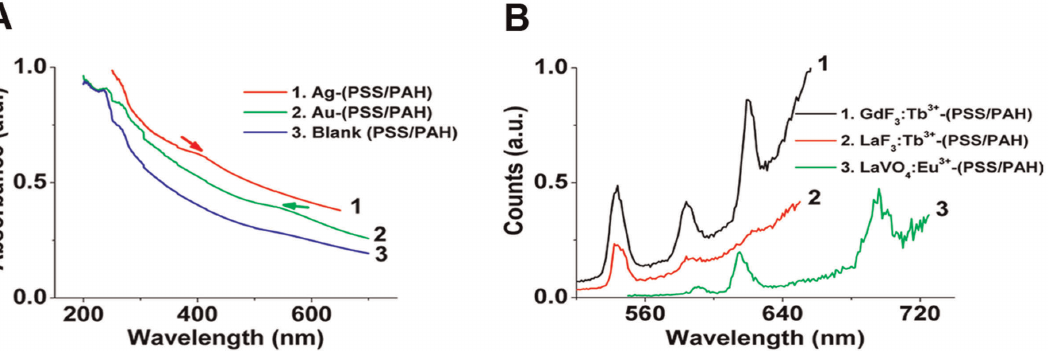
Figure 1. Optical properties of nanoparticles-loaded PSS/PAH capsules. (a) UV-Vis absorbance spectra of (1) Ag and (2) Au nanoparticles- loaded PSS/PAH capsules and (3) blank PSS/PAH capsules; (b) photoluminescence emission spectra of (1) GdF 3 :Tb 3 + (5%), (2) LaF 3 :Tb 3 + (5%) and (3) LaVO 4 :Eu 3 + (5%) nanoparticles-loaded PSS/PAH capsules [Excitation wavelength used was 488 nm for GdF 3 :Tb 3 + (5%) and LaF 3 :Tb 3 + (5%) and 465 nm for LaVO 4 :Eu 3 + (5%)].